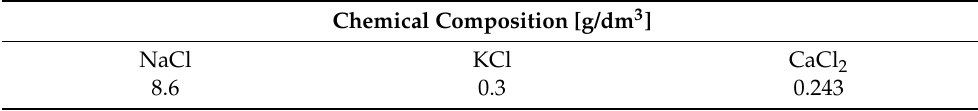
Table 3. Chemical composition of Ringer’s